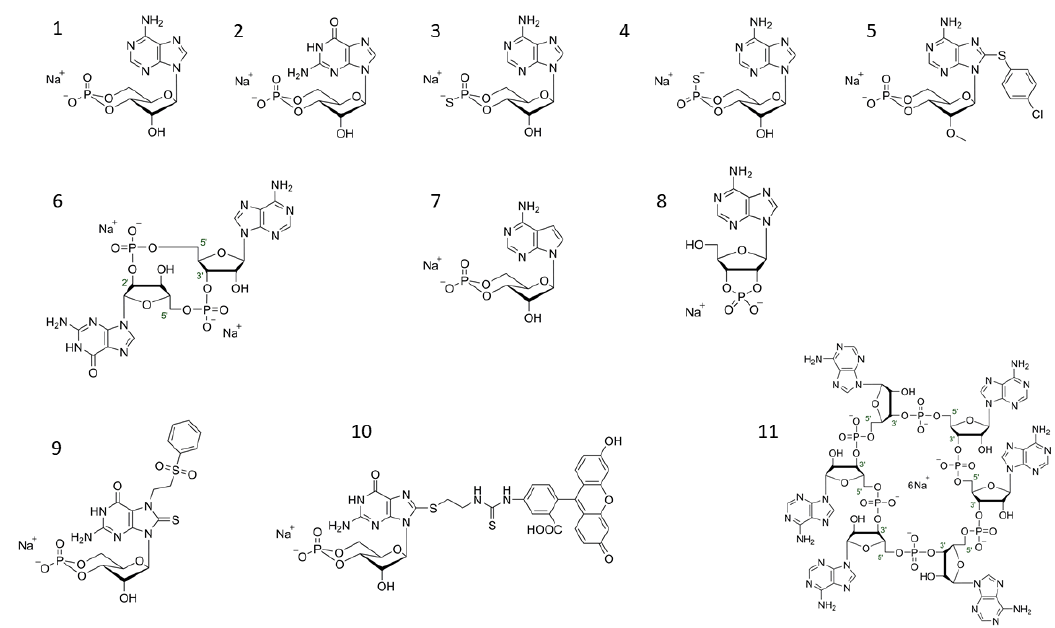
Figure 1. Selected structures of cyclic nucleotides ( 1 ) cAMP (Adenosine-3 ′ , 5 ′ -cyclic monophosphate syn-conformation), ( 2 ) cGMP (Guanosine-3 ′ , 5 ′ -cyclic monophosphate), ( 3 ) Rp -cAMPS (Adenosine-3 ′ , 5 ′ -cyclic monophosphorothioate, Rp - isomer; PKA antagonist), ( 4 ) Sp -cAMPS (Adenosine-3 ′ , 5 ′ -cyclic monophosphorothioate, Sp -isomer ; PKA agonist), ( 5 ) 8- pCPT-2 ′ -O-Me-cAMP (8-(4-Chlorophenylthio)-2 ′ -O-methyladenosine-3 ′ , 5 ′ -cyclic monophosphate; EPAC activator), ( 6 ) cGAMP(2 ′ -5 ′ )/2 ′ 3 ′ -cGAMP/2 ′ ,5 ′ -3 ′ ,5 ′ -cGAMP (Cyclic (guanosine-(2 ′ − > 5 ′ )-monophosphate-adenosine-3 ′ − > 5 ′ )- monophosphate)STING ligand), ( 7 ) 7-CH-cAMP/cTuMP (7-Deazaadenosine-3 ′ , 5 ′ -cyclic monophosphate ; HCN ligand), ( 8 ) 2 ′ ,3 ′ -cAMP (Adenosine-2 ′ ,3 ′ -cyclic monophosphate), ( 9 ) 7-PS(O) ₂ E-8-T-cGMP ( 7-[2-(Phenylsulfonyl)ethyl]-8-thioguanosine-3 ′ , 5 ′ -cyclic monophosphate ; selective CNG olf/ret ligand), ( 10 ) 8-[Fluo]-cGMP/8-[Fluo]-AET-cGMP (8-(2-[Fluoresceinyl]aminoethylthio)guanosine- 3 ′ , 5 ′ - cyclic monophosphate PKG ligand, general cGMP-like binding fluorescence tool), ( 11 ) c-hexa-AMP; cyclic hexaadenylate (Cyclic hexa-adenosine monophosphate ; CRISPR-CAS III ligand).